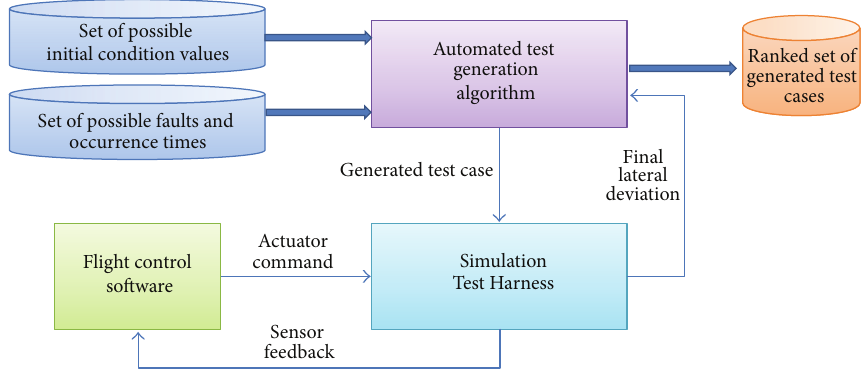
Figure 5: Automated test generation architecture for UAV flight control software testing.